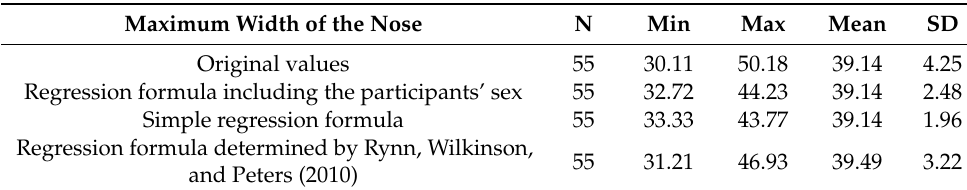
Table 7. Descriptive statistics of maximum nose width calculated for each regression formula.